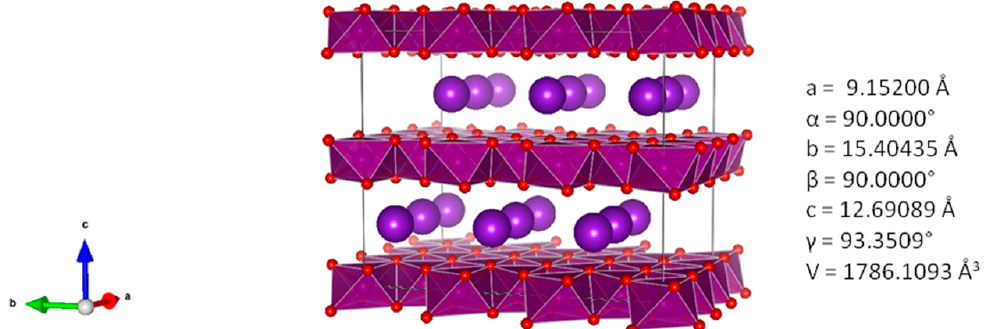
Figure 3. Density functional theory (DFT)-computed polyhedral crystal structure of monoclinic K 0.5 MnO 2 [31]. Intercalated potassium ions are always localized near to Mn 3+ positions. The calculated d-spacing value for water-free structure is 6.35 Å. In presence of additional water in-between MnO 2 layers, typical value amounts to ≈ 7.1 Å.